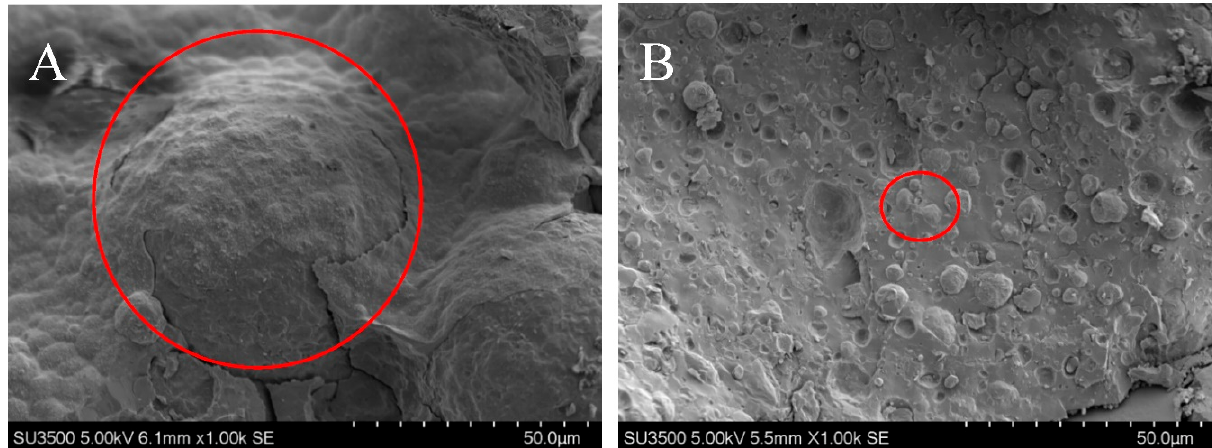
Figure 4. The Cryo-SEM images of the 1:10 emulsions before ( A ) and after ( B ) high-intensity ultrasound emulsification. The spherical objects in the red circle represent emulsion droplets.